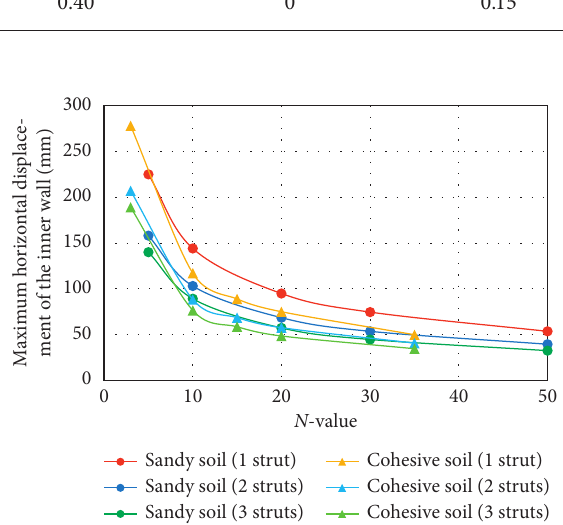
Figure 8: Relationship between N -value of sandy soil and cohesive soil and maximum horizontal displacement of the inner wall.